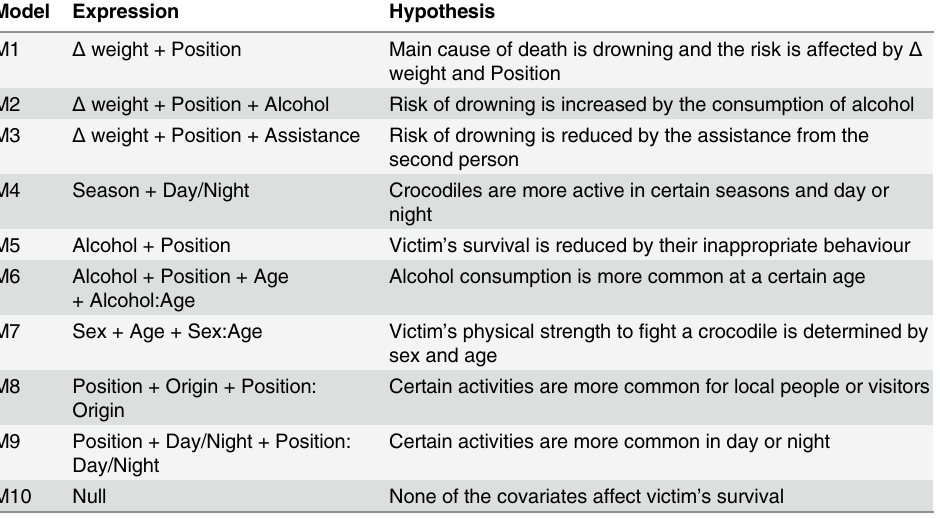
Table 1. A priori candidate models of binary logistic regression to explain the fate of a saltwater croc- odile attack. Model